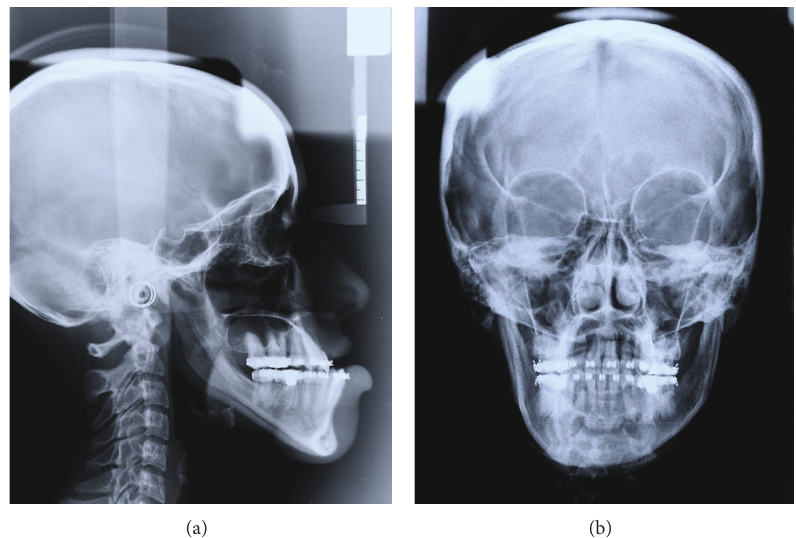
Figure 11: Presurgical: (a) lateral, and (b) PA cephalograms.